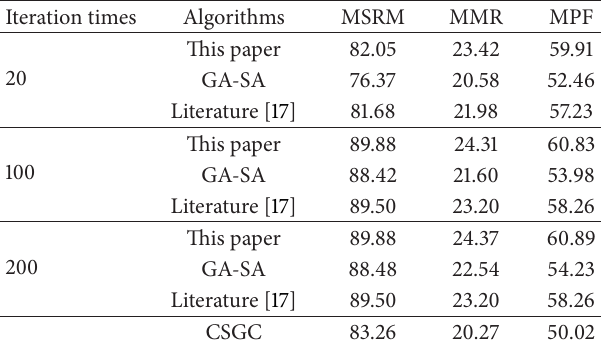
Table 1: Network benefits comparison with other classic serial algorithms under different iteration times ( 𝑀 = 𝑁 = 5 ).